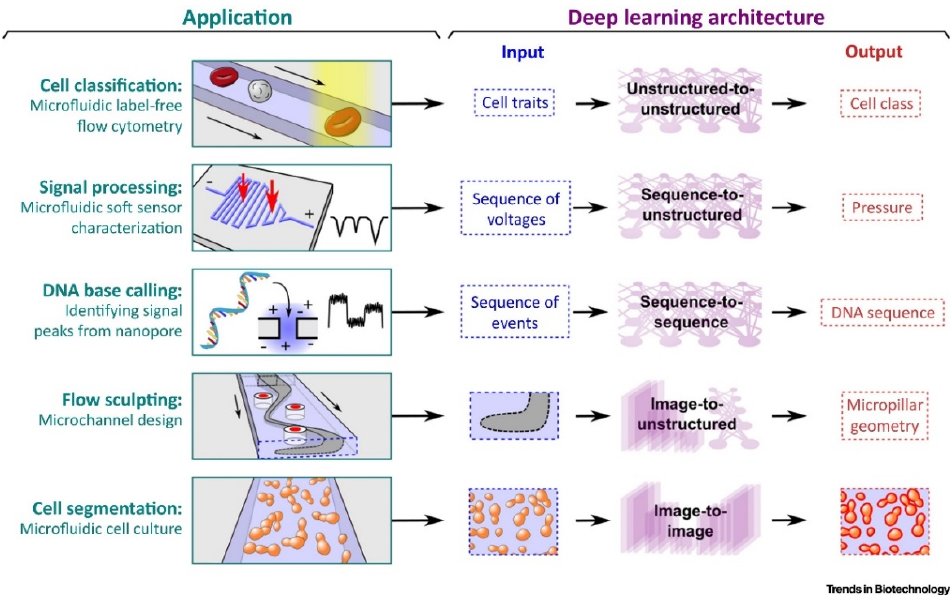
Figure 3. Illustration of applications showing different DL architecture. Reproduced with permission from [101].